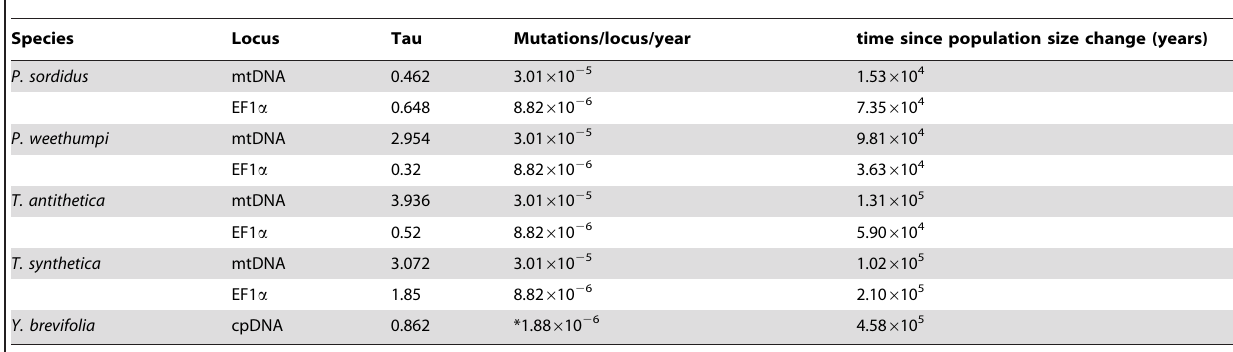
Table 6. Tau calculated from empirical data in DNAsp v. 5, by species and by locus.